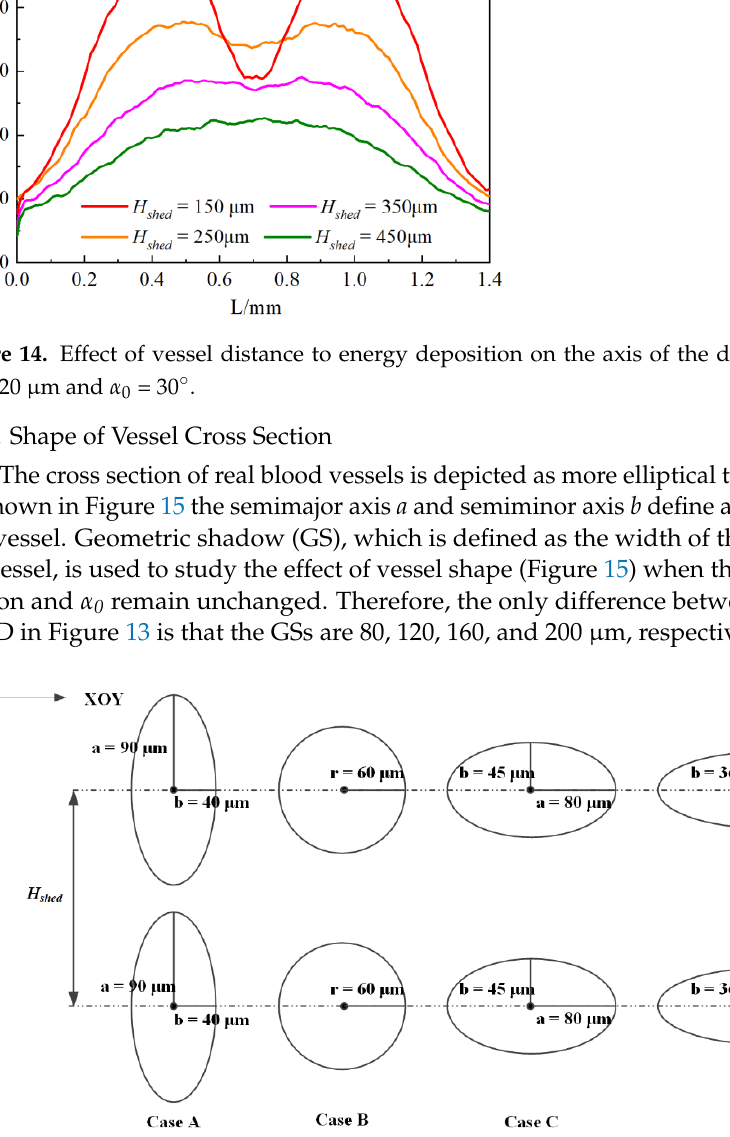
Figure 13. Effect of cross angle ( α 0 ) on energy deposition in the axis of the deep blood vessel at D = 120 μm and H cshad = 250 μm. ( a ) Energy deposition along the vessel axis. ( b ) Diagram of energy deposition in the deep vessel at α 0 > 20° and H cshad = 250 μm.